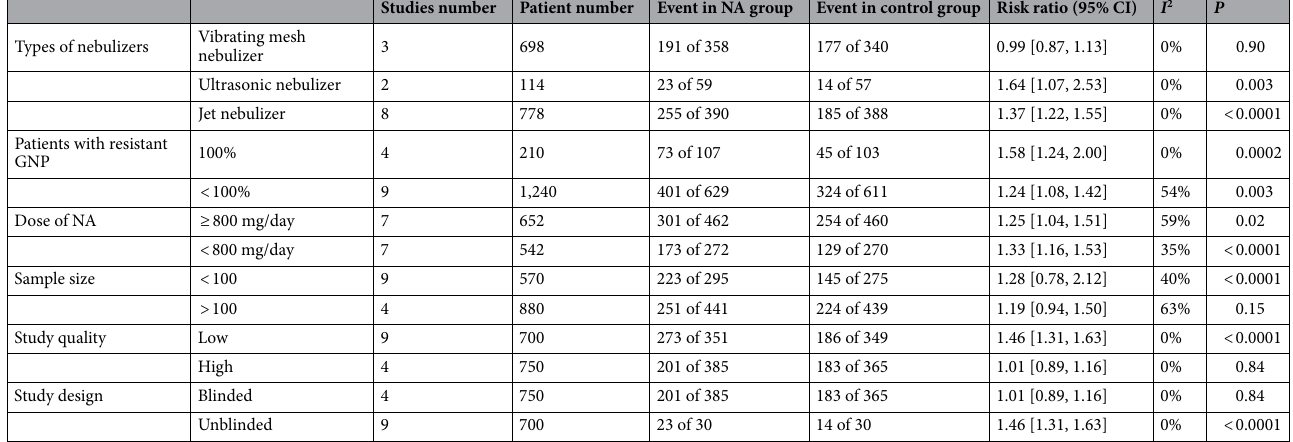
Table 3. Subgroup analysis on primary outcome of clinical response. NA = nebulized amikacin; CI = confidence interval; GNP = gram-negative